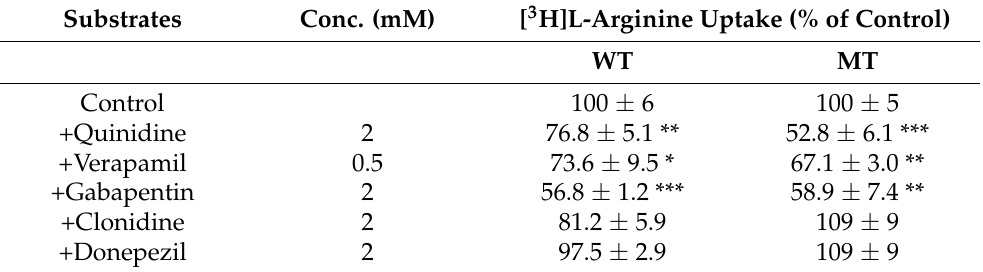
Table 5. Inhibitory effect of various pharmacological drugs on [ 3 H]L-arginine uptake by ALS cell lines.